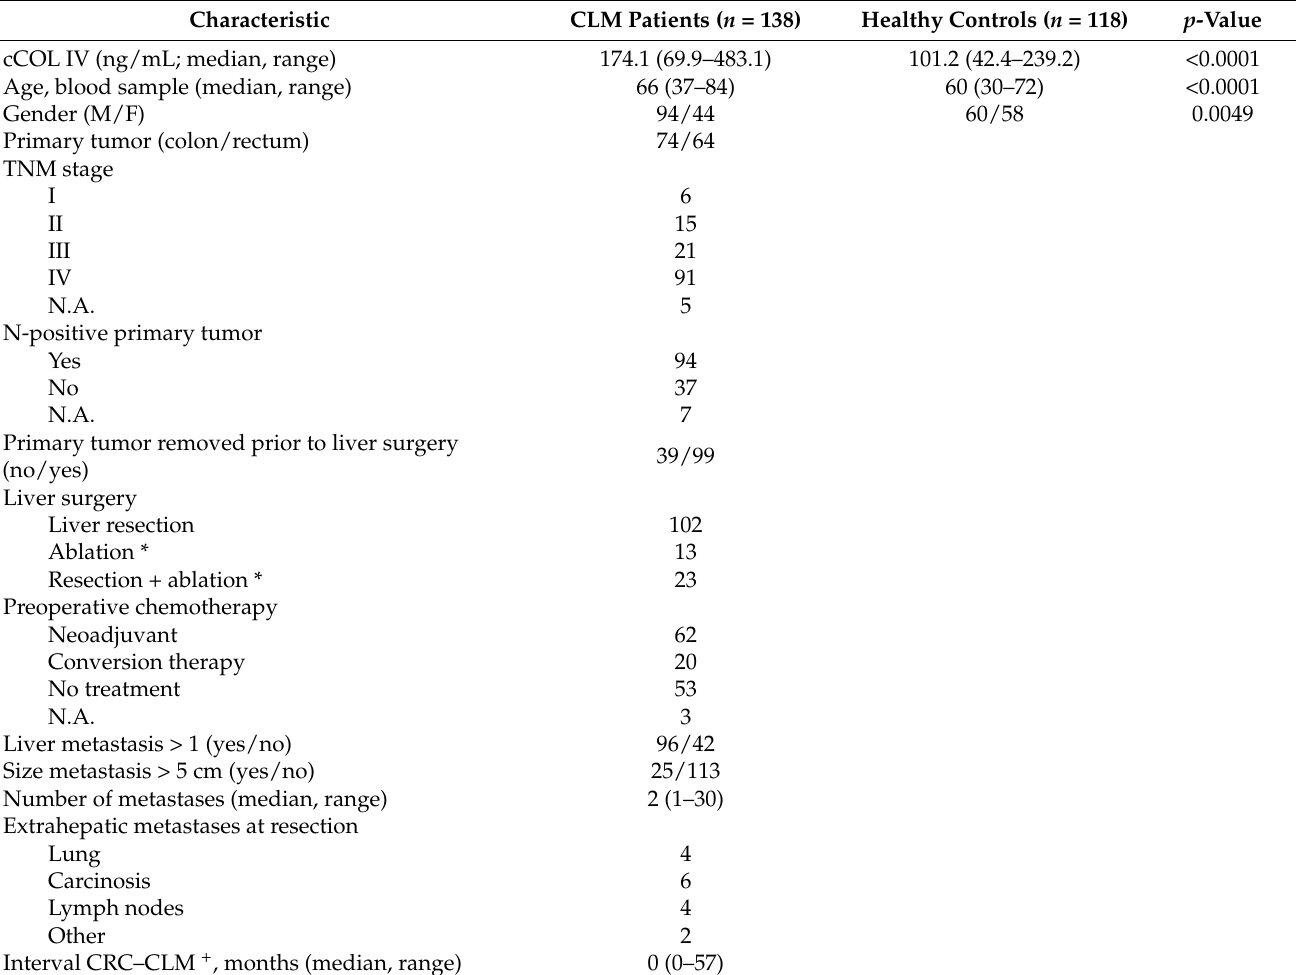
Table 3. Patient characteristics of the plasma cohort.